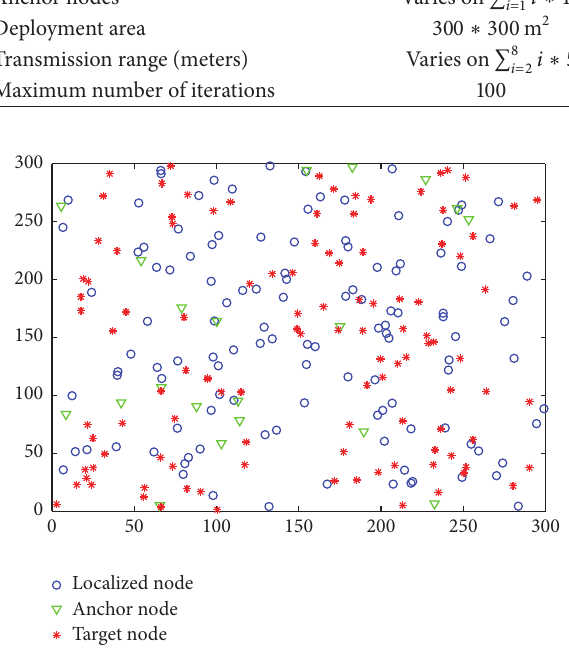
Figure 2: PSO for WSN localization.